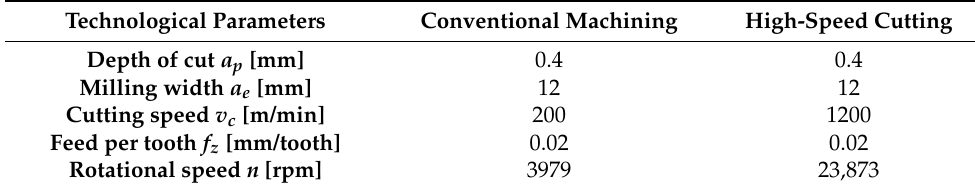
Table 4. Applied technological parameters during